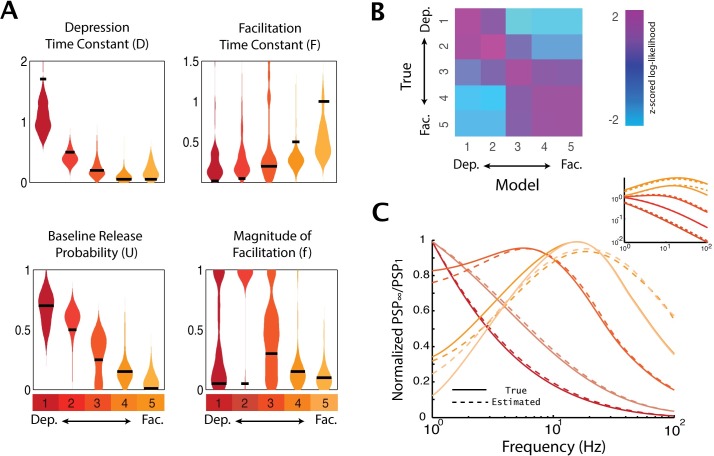
Estimation of the TM parameters.A) Bootstrap distribution of the estimated parameters {D,F,U,f} for synapses with five different types of STP, from strong depression to strong facilitation (left to right). Here only the results for the strongest excitatory synapses are shown. The black horizontal bar in each distribution represents the true value for each artificial synapse (Table 1). B) z-scored log-likelihood values for strong synapses modeled with the parameters of each possible model. Even though the optimization of the TM-GLM is not guaranteed to be convex, we can accurately discriminate between different types of STP. Note that the highest likelihood is along the diagonal where the true type of STP corresponds to the same type modeled. C) Normalized steady-state postsynaptic potentials in response to a regular train of presynaptic spikes with different input frequency for true parameter sets (solid) and estimated parameters (dashed). Inset shows the unnormalized steady-state response on a log-scale.